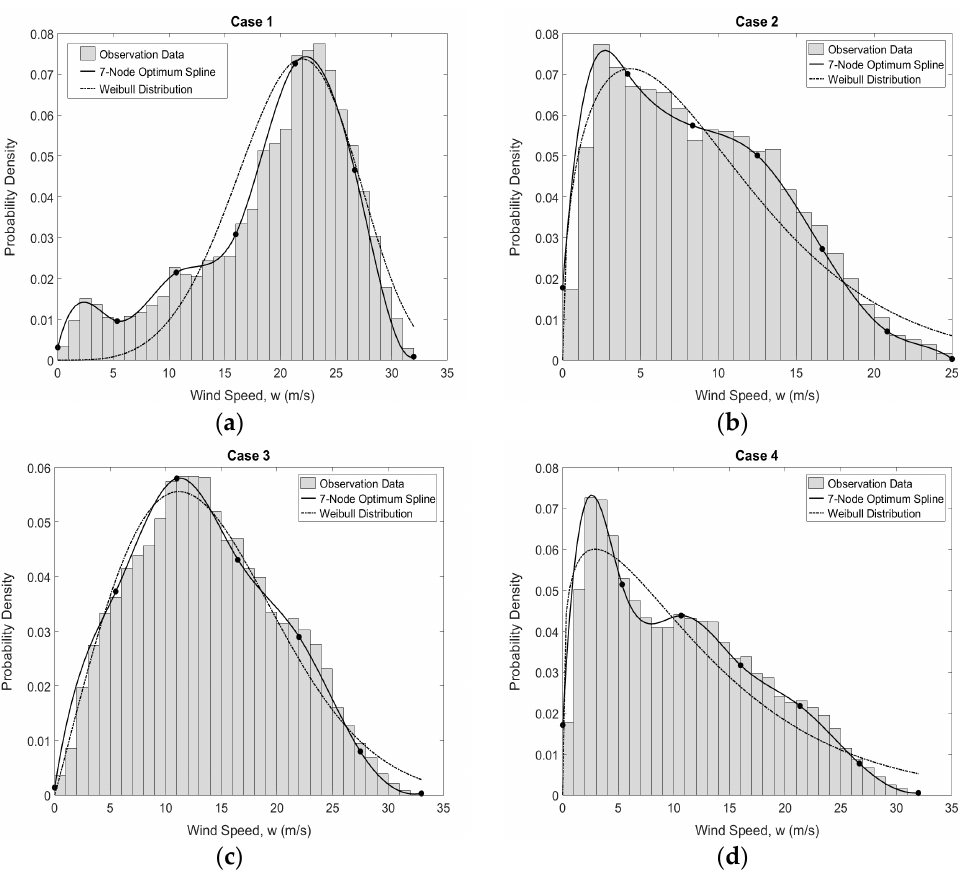
Figure 3. Comparison of the spline-based and Weibull fits with the observed data. ( a ) Multimodal distribution 1; ( b ) Multimodal distribution 2; ( c ) Unimodal distribution; ( d ) Multimodal distribution